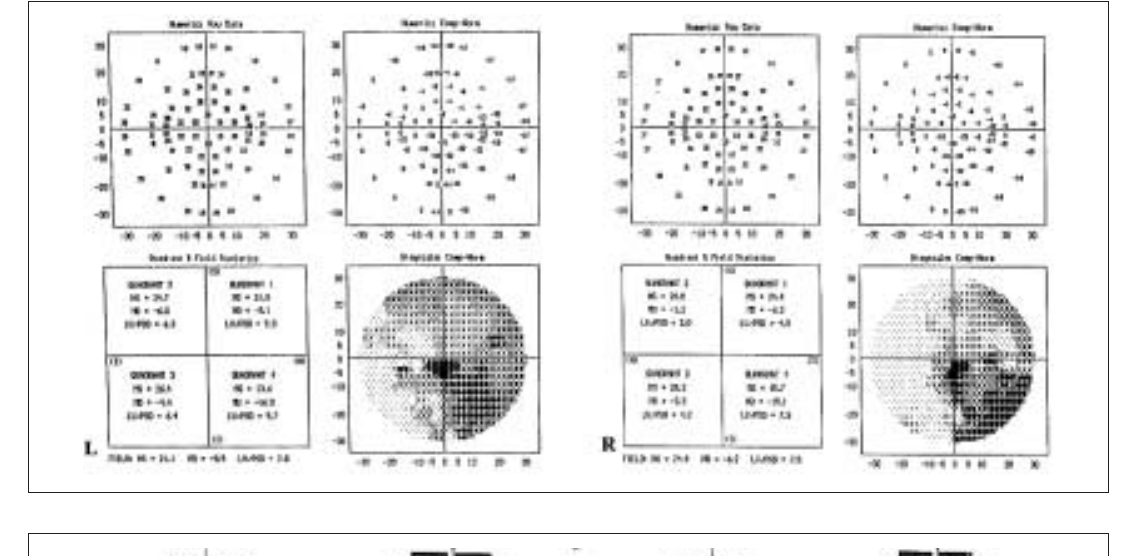
before and after HBO